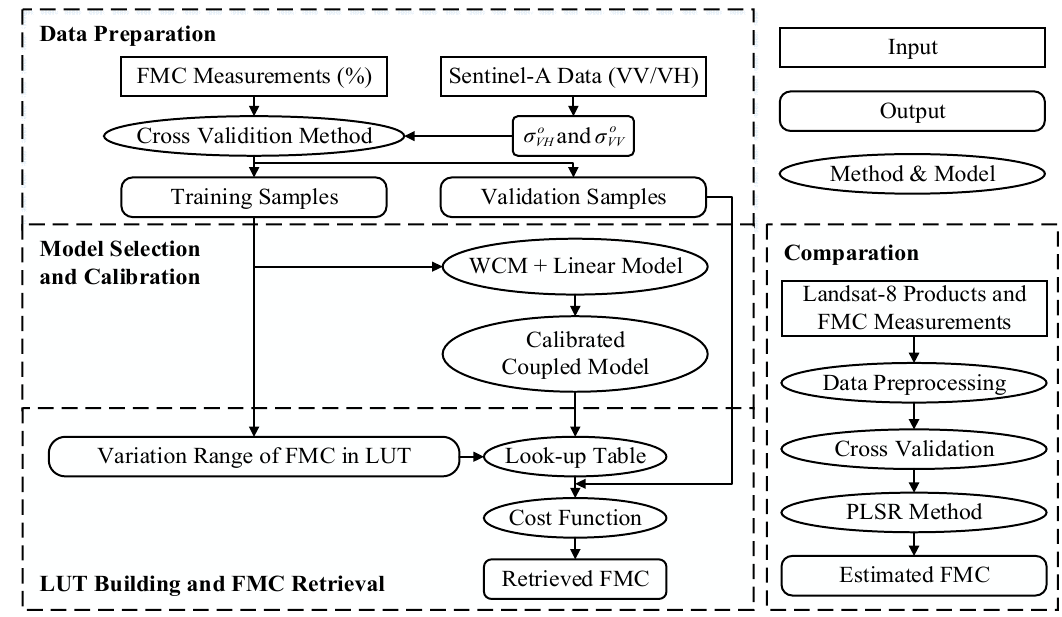
Figure 1. Methodological flowchart showing the process for forest fuel moisture content (FMC) estimation from dual polarimetric C-band Sentinel-1A data. estimation from dual polarimetric C-band Sentinel-1A